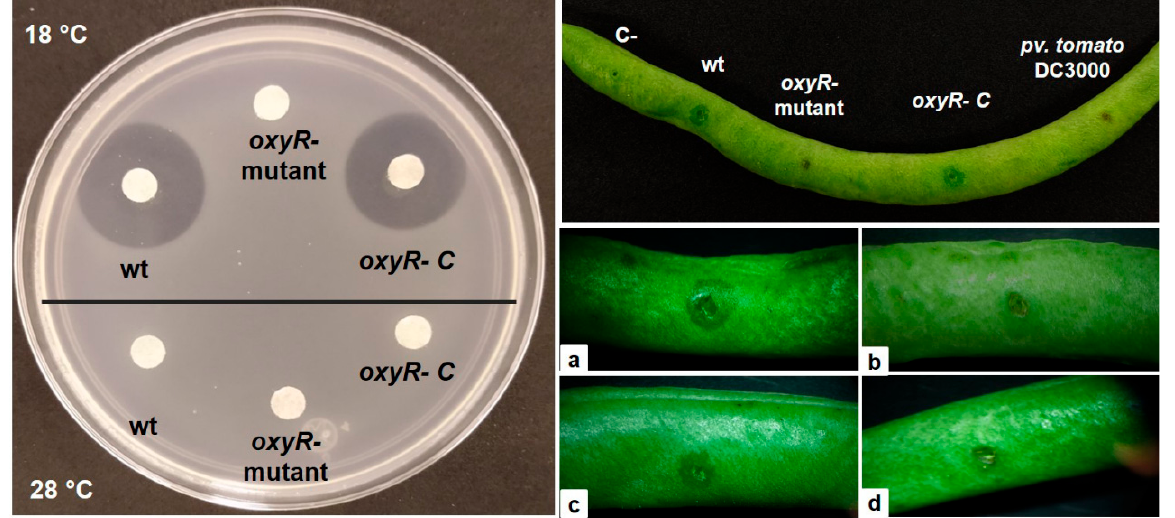
Figure 2. Phaseolotoxin synthesis test and bean pod pathogenicity assays. Left panel shows the phaseolotoxin production assays in vitro. Right panel shows the bean pod assays. ( a ) P. savastanoi pv. phaseolicola wt strain. ( b ) oxyR-mutant strain. ( c ) oxyR- complemented mutant strain [ oxyR- C ]. ( d ) P. syringae pv. tomato DC3000 strain.